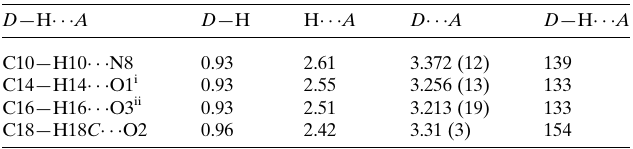
Table 1 Hydrogen-bond geometry (A˚ , (cid:4) ).